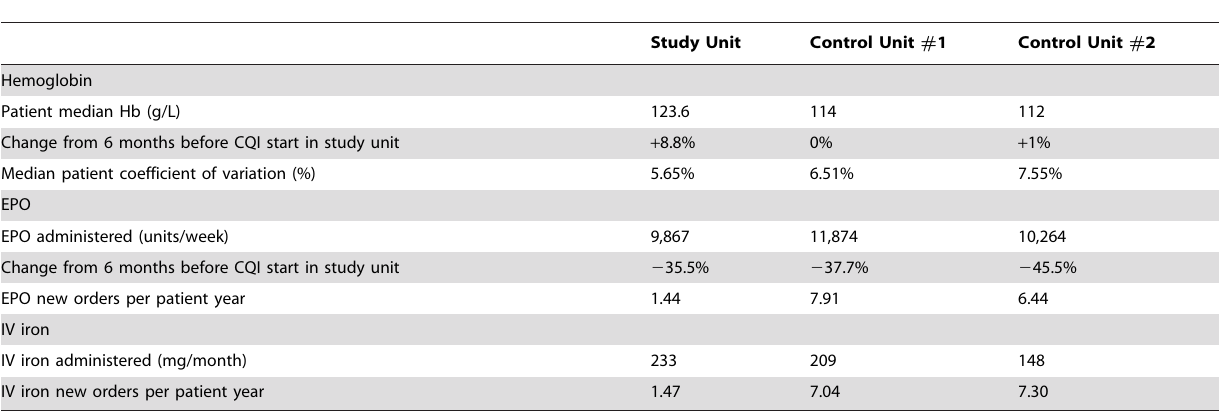
Table 2. Selected data on patients in the study and two control units in months 13–18 after start of CQI in the study unit.